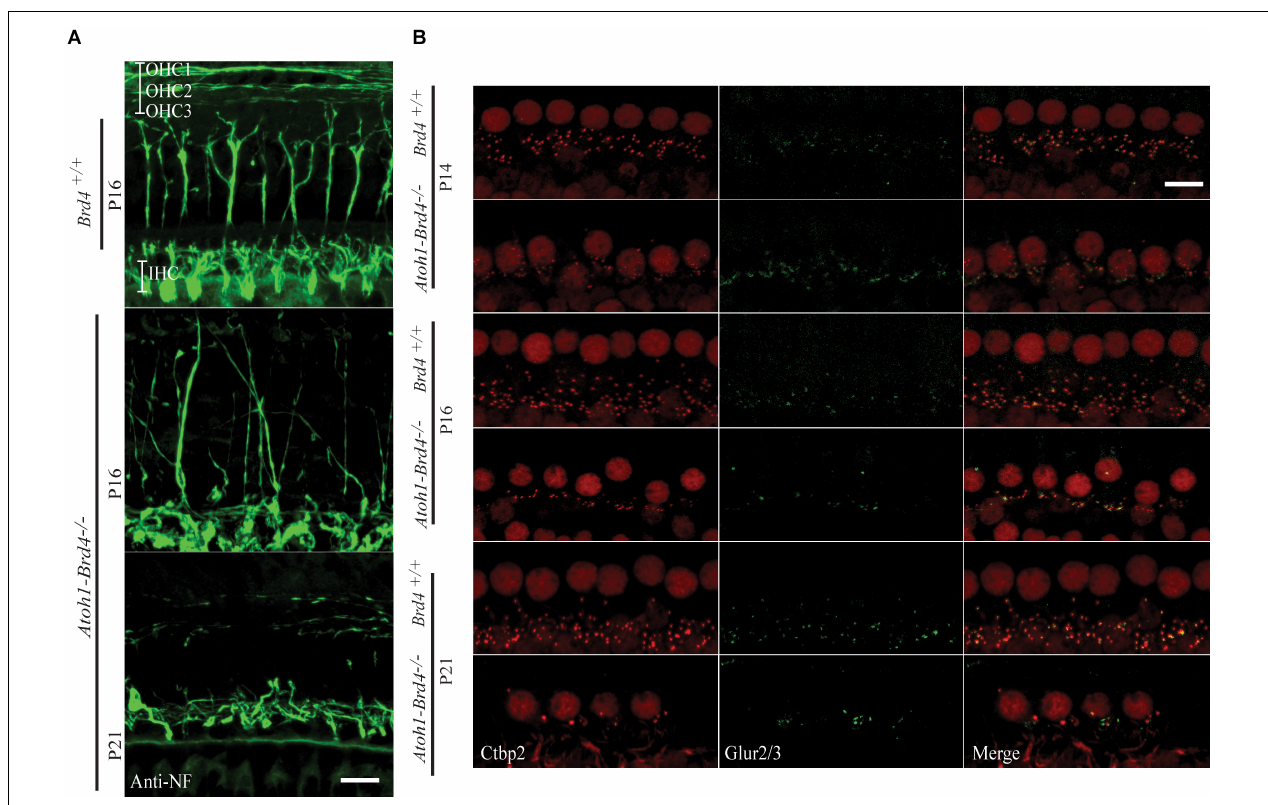
FIGURE 3 | Innervation defects and degeneration of ribbon synapses. (A) Z-stack projections showing neurofilament fiber bundles with improper fasciculation and eventual degeneration in whole mount mouse cochleae Atoh1-Brd4 − / − . Nerve fibers were immunolabeled with an antibody against neurofilament heavy chain (green) (bar scale: 20 µ m). (B) Z-stack projections of mice IHCs stained for anti-RIBEYE/CtBP2 (red) and GluR2/3 (green). Reduced numbers of IHC paired CtBP2-GluR2/3 ribbons were observed starting at P14 and severe loss in synaptic ribbon formation was observed by P21 (bar scale: 10 µ